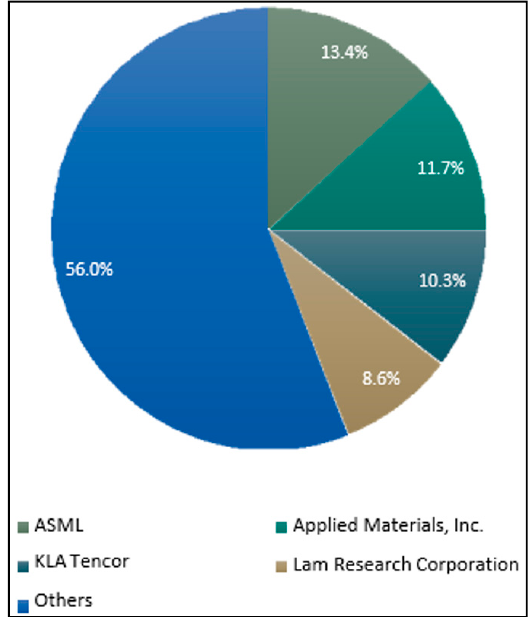
Figure 24. Global e-beam Wafer inspection system market share.